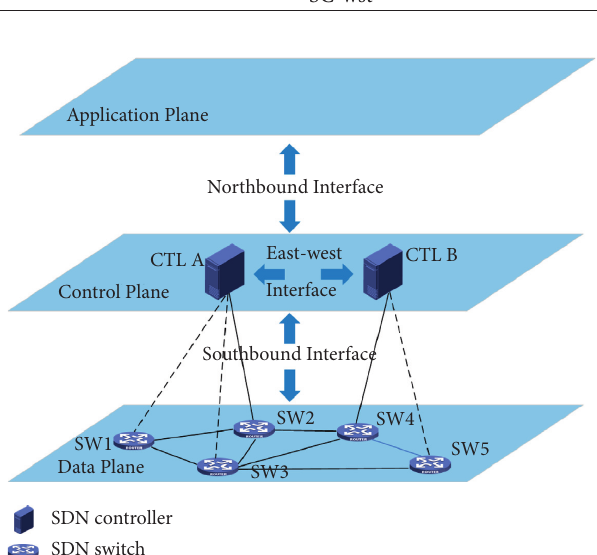
Figure 1: The infrastructure of